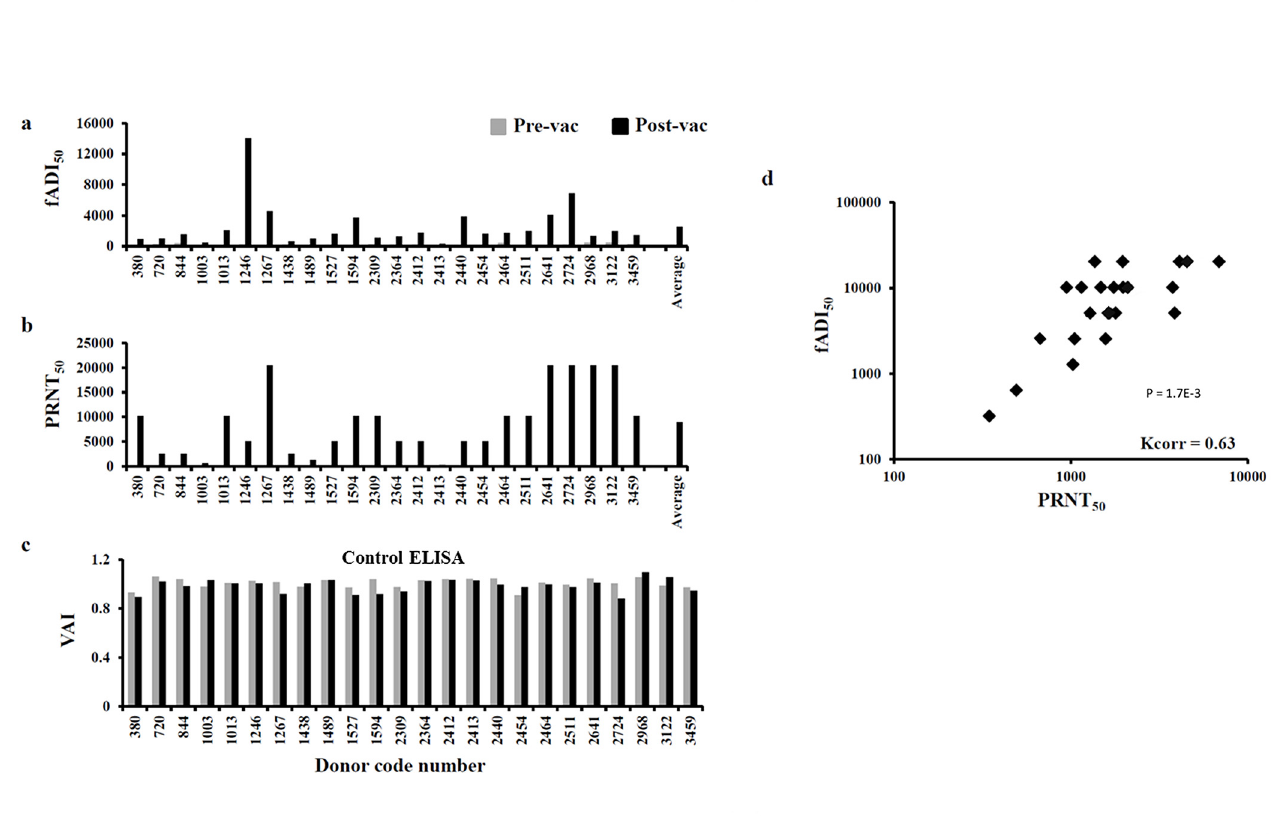
Fig 6. Correlation between fADI and PRNT methods for Yellow Fever vaccine virus. fADI 50 were calculated from the Virus Attachment Indexes using a mathematical approximation model, more details in the text. The fADI titers for all the pre-vaccination sera samples were found very low. fADI displayed a considerable donor-to-donor variation in the capacity of post-vaccination donor sera to block attachment of vaccine strain 17DD of Yellow Fever virus to Vero cells (a). PRNT 50 data were obtained for the same sera samples independently by a commercial vendor (b). Control ELISA did not reveal a reduction of the reporter fluorescence signal, thus showing zero competition between the sera antibodies and the virus specific labeling antibodies used in the assay (c). A considerable positive correlation between the fADI and PRNT data for post-vaccination sera samples was found